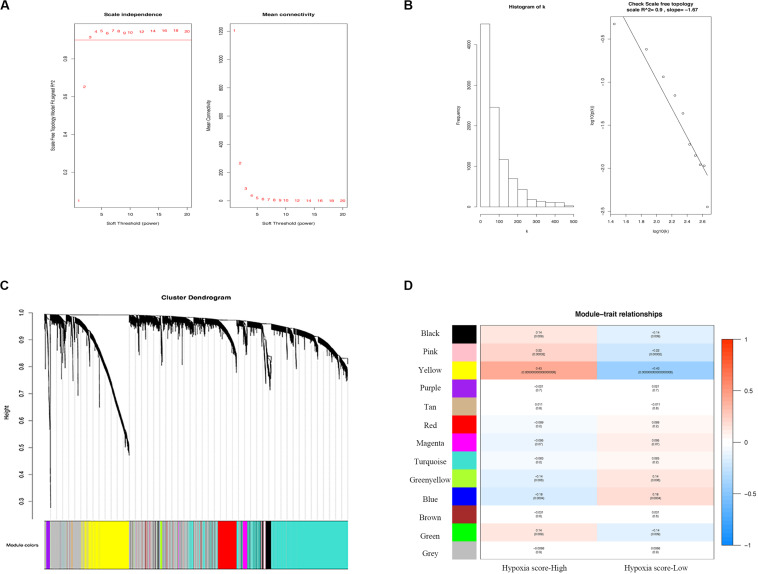
Determination of modules correlated with the hypoxia of melanoma in the WGCNA. (A) Analysis of the scale-free fit index and the mean connectivity for various soft-thresholding powers. (B) Checking the scale free topology when β = 3. Correlation coefficient = 0.9, which showed scale-free topology. (C) Dendrogram of genes clustered according to a dissimilarity measure (1-TOM). (D) Heatmap of the correlation between module Eigengenes and hypoxia. WGCNA, the weighted gene co-expression network analysis.